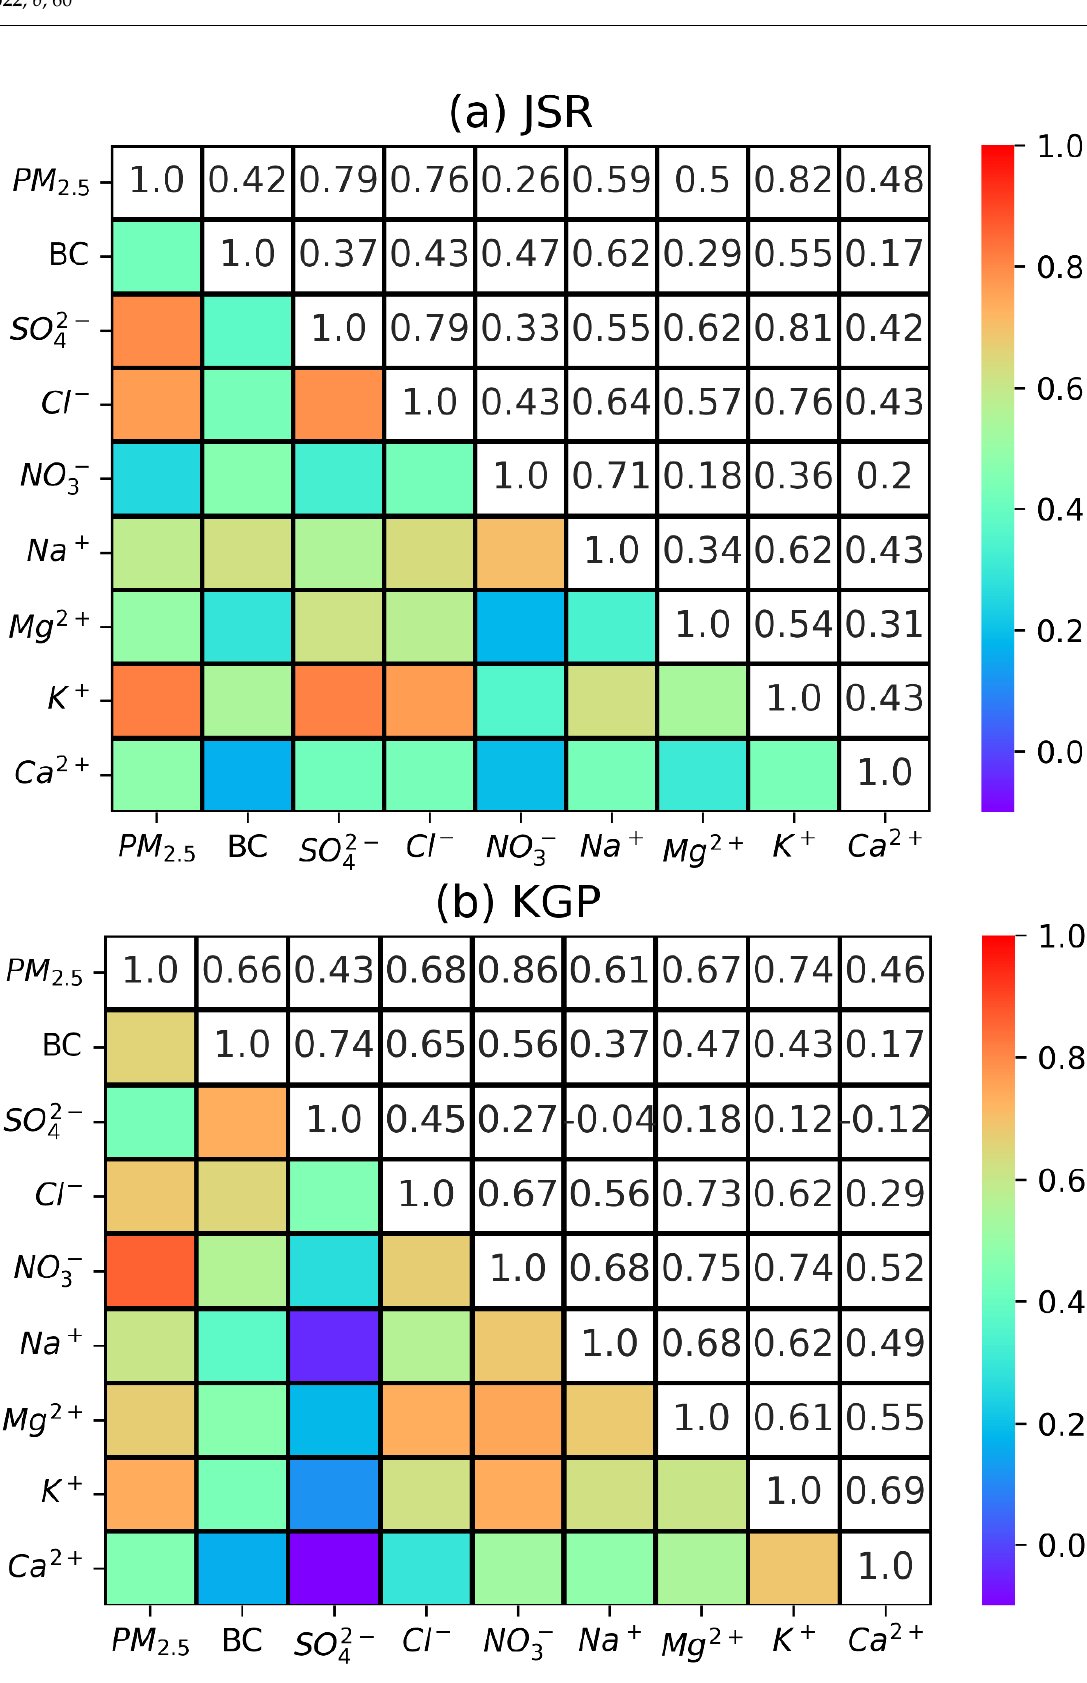
Figure 6. Scatterplots of the BC versus PM 2.5 concentrations at ( a ) JSR and ( b ) KGP sites.